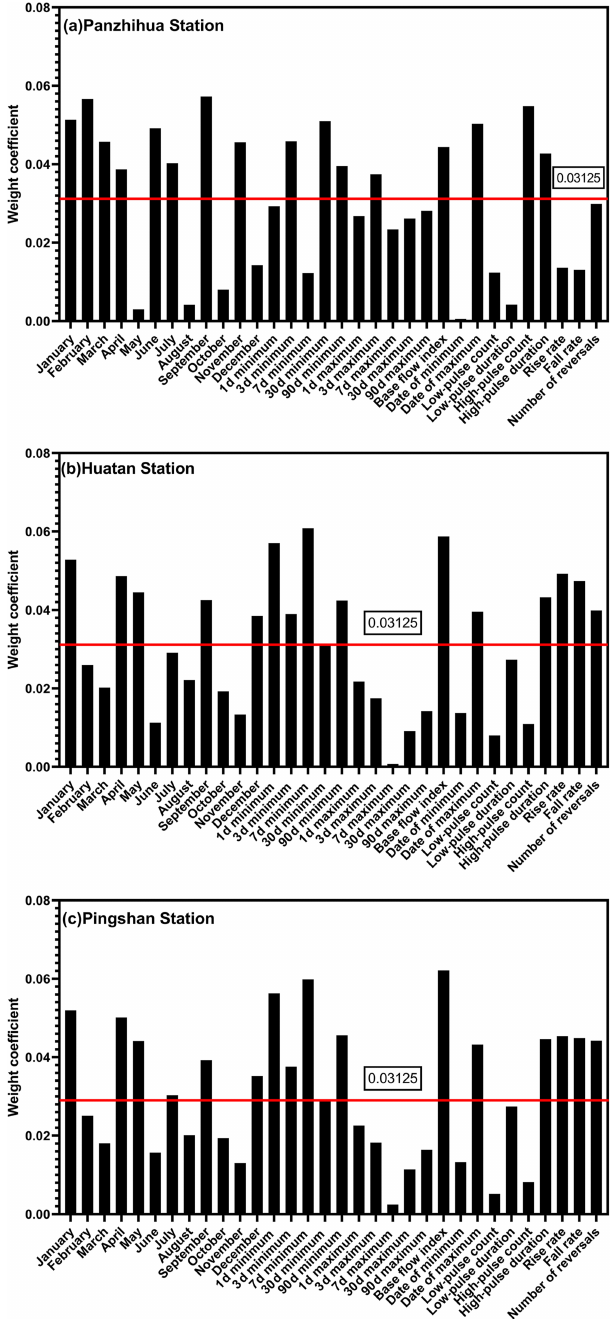
Figure 3. Value of weights of 32 IHA parameters in (a) Panzhihua Station, (b) Huatan Station and (c) Pingshan Station. The red line is the equal weight line (1 / 32 = 0 .